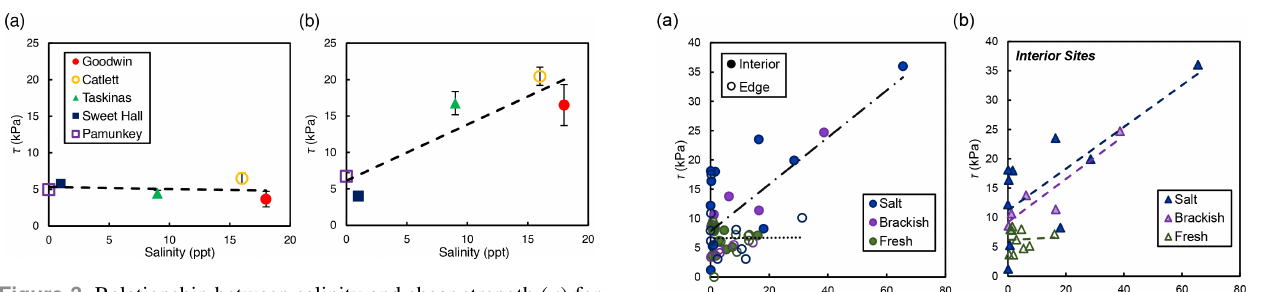
Figure 3. Relationship between salinity and shear strength ( τ ) for edge sites (a) and interior sites (b) . Each point represents the depth- averaged shear strength value for the upper 30cm of the soil pro- file, and error bars represent the standard error associated with 10 replicate profiles for each site and location. Only the interior sites yielded a significant relationship between shear strength and salinity ( R 2 = 0 . 81; p = 0 . 04). Figure 4. Average shear strength ( τ ) values for the marsh edge and the interior locations. The salt marsh locations are Goodwin Islands and Catlett Islands, the brackish marsh location is Taskinas Creek, and the freshwater marsh locations are Sweet Hall Marsh and the Pamunkey Indian Reservation. Each column represents the depth- averaged shear strength for the upper 30cm of soil of each marsh type, and error bars represent the standard error of 10 replicate shear strength profiles for each marsh type.